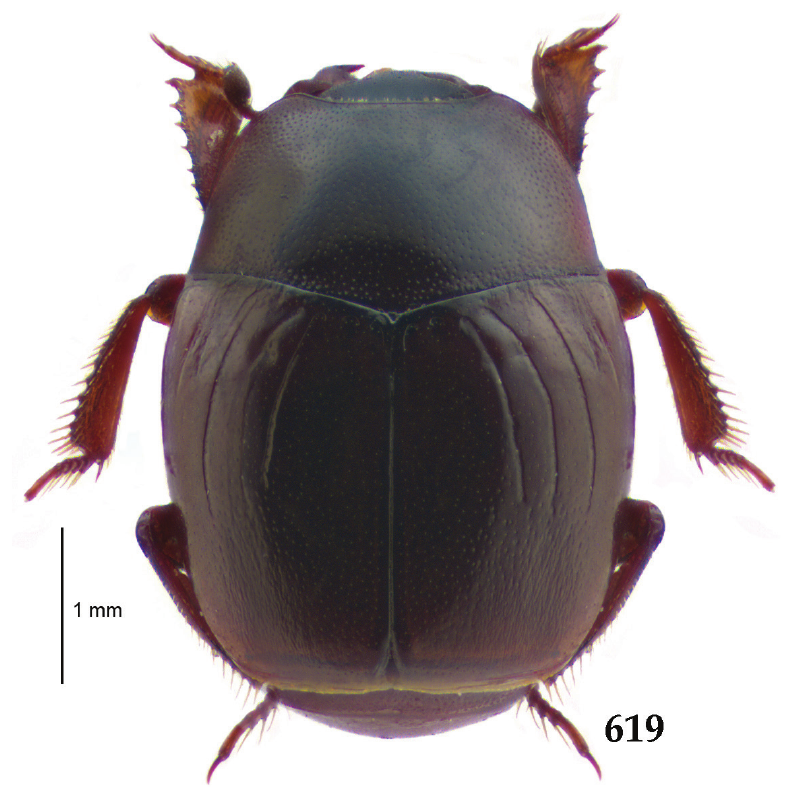
Figure 619. Tomogenius australis Dahlgren, 1976 habitus, dorsal